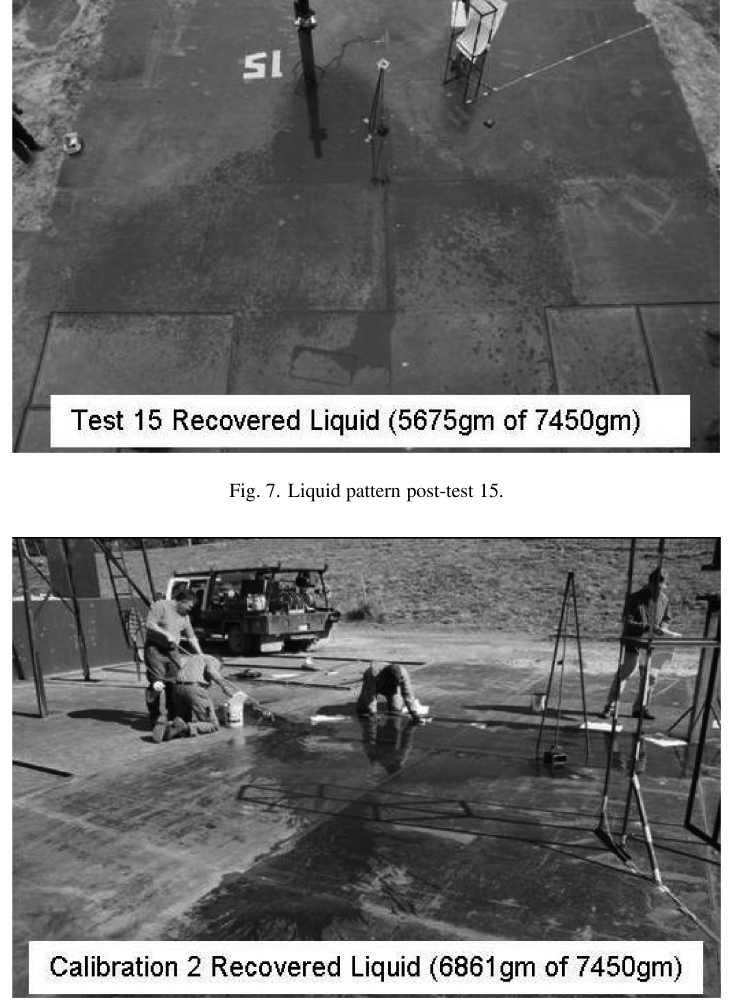
Fig. 8. Calibrating the recovery